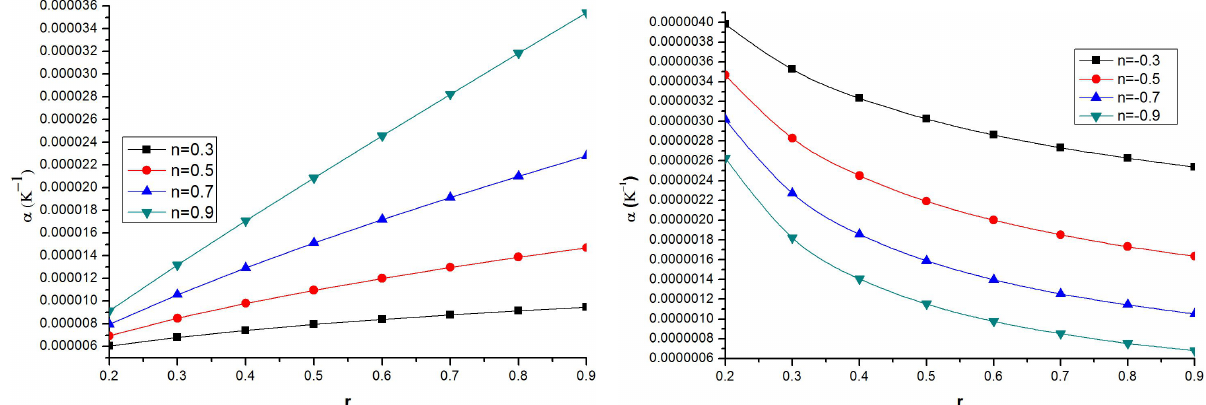
Figure 2: Represents variation in Coeflcient of thermal expansion versus radial coordinate corresponding to positive and negative values of inhomogeneity